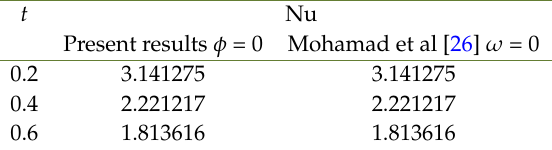
Table 5. Comparison of Nusselt number values at Pr =6.2. t